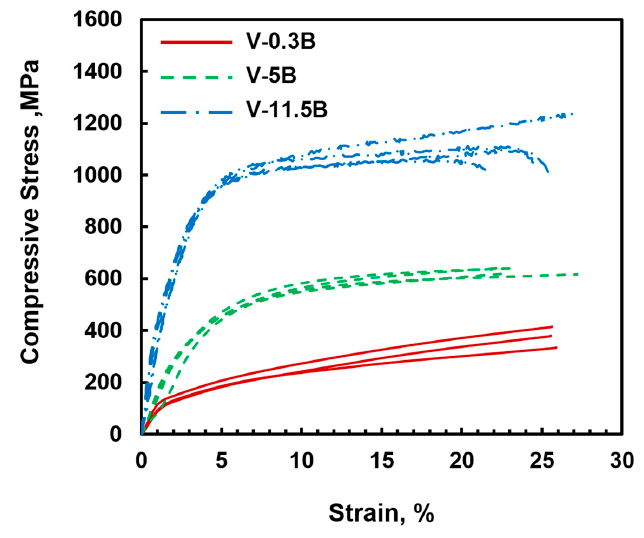
Figure 4. Compressive engineering stress vs. strain curves at room temperature of alloys V ‐ 0.3B, V ‐ 5B and V ‐ 11.5B. and